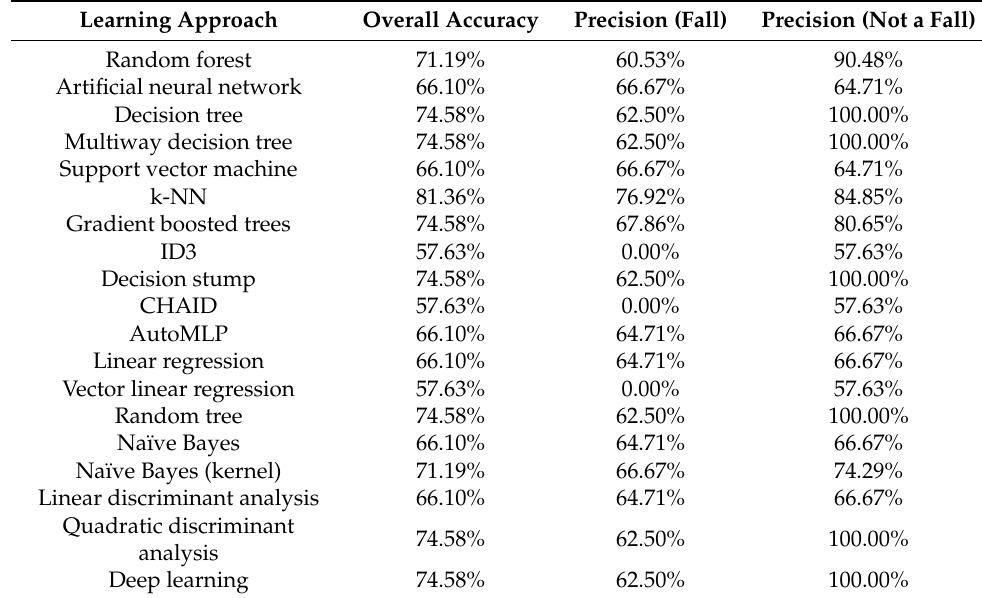
Table 4. Summary of the performance characteristics of the different machine learning methods that we developed in RapidMiner to detect falls and other activities using the second dataset